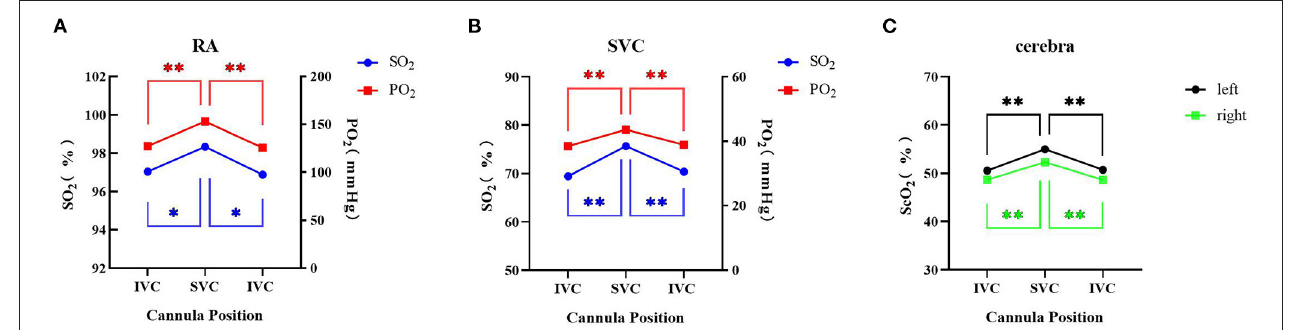
FIGURE 2 | Overall blood gas analysis and cerebral oxygen saturation with different positions of the drainage cannula on femoral VA ECMO. (A) Right radial artery SO 2 and PO 2 ; (B) superior vena cava SO 2 and PO 2 ; (C) cerebral oxygen saturation. * Indicates P < 0.05 between IVC and SVC; ** Indicates P < 0.01 between IVC and SVC. IVC, inferior vena cava; SVC: superior vena cava; RA, right radial artery; SO 2 , oxygen saturation; PO 2 , oxygen partial pressure; ScO 2 , cerebral oxygen saturation.